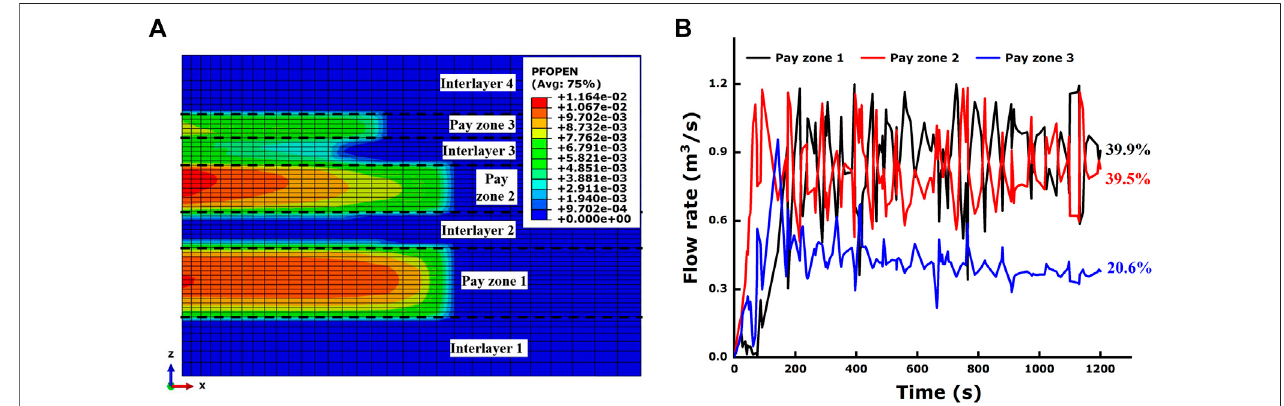
FIGURE 11 | Fracture geometry and fl ow rates of the fl uid into pay zones in the model with the new perforating scheme. (A) Hydraulic fracture geometry; (B) Flow rates of fl uid into the three pay zones.